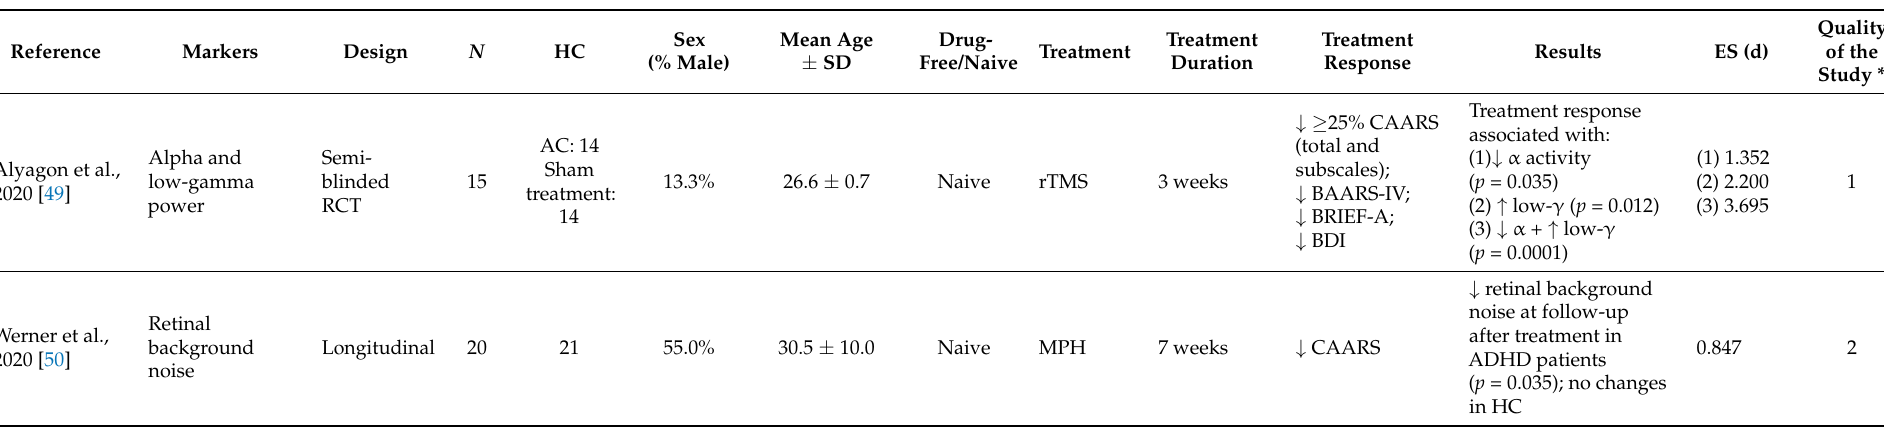
Table 4. Summary of the studies about electrophysiological markers of treatment response in adult